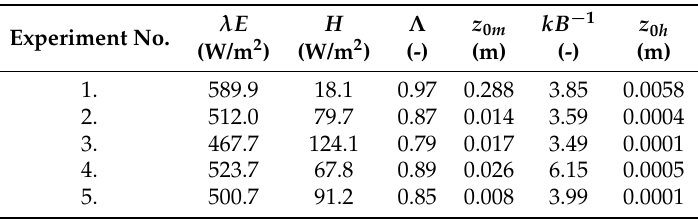
Table 4. Results of simulated heat flux densities and roughness length at the EC footprint scale for the five